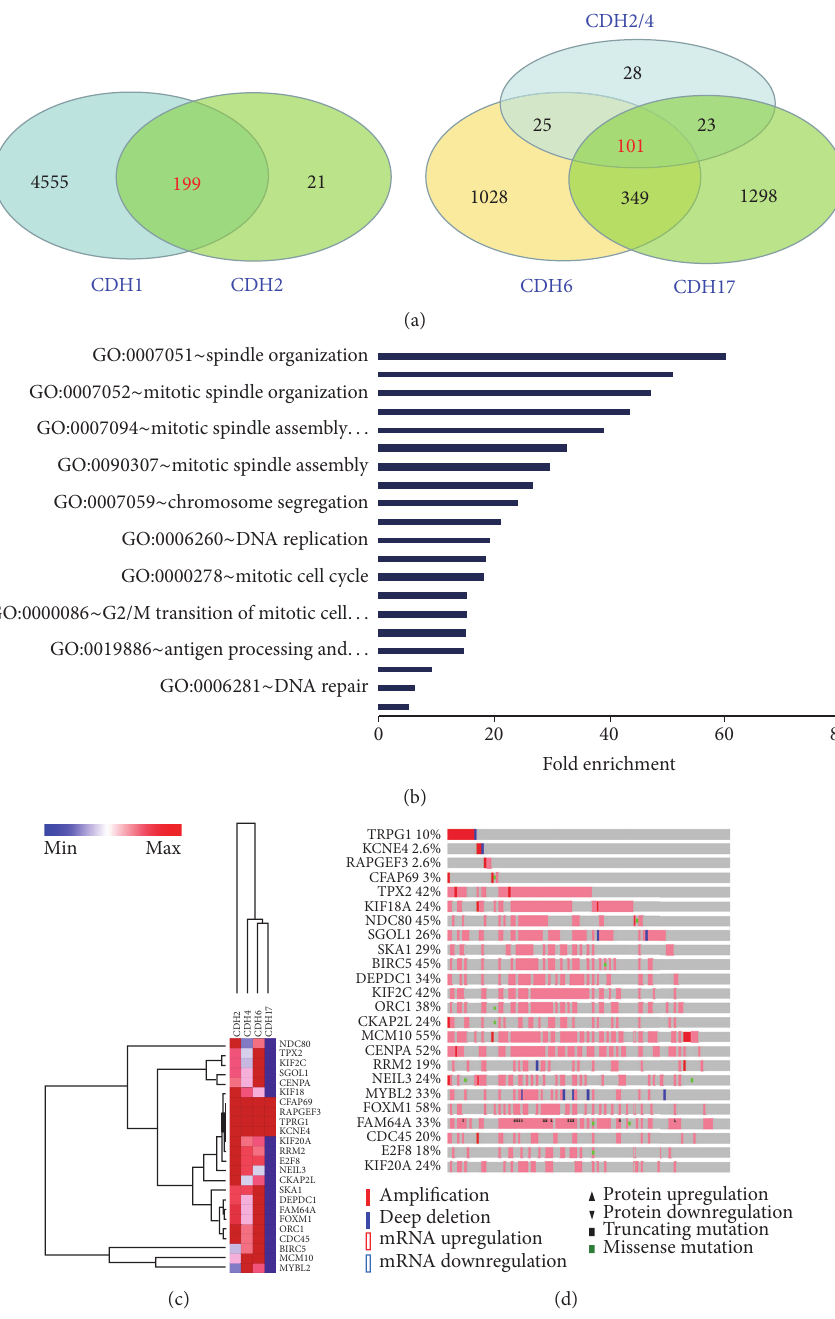
Figure 2: CDH2/4/6/17-enriched genes in breast cancer. (a) Venn diagrams showing the number of the overlaps between CDH1- and CDH2- enriched genes (left panel) and the overlaps between CDH2-, CDH4-, CDH6-, and CDH17-enriched genes (right panel). The enriched genes for each individual altered cadherin were retrieved with cBioPortal enrichments module from TCGA provisional breast datasets (complete tumor group, 𝑛 = 960 ). CDH1 was queried with EXP < −2.0 MUT HOMDEL PROT < −2.0 and other CDHs were queried with default parameters. The genes were selected with 𝑝 < 0.01 (derived from Student 𝑡 -test) and 𝑞 < 0.01 (derived from Benjamini-Hochberg procedure). EXP, mRNA expression level; MUT, mutation; HOMDEL, homozygous deletion; PROT, protein level as determined by reverse phase protein assay (RPPA). (b) Gene Ontology (GO) analysis of CDH2/4/6/17-enriched genes with DAVID Bioinformatics Resources 6.8. Annotation, Visualization, and Integrated Discovery. (c) Clustering analysis of top 24 out of 101 CDH2/4/6/17-enriched genes.